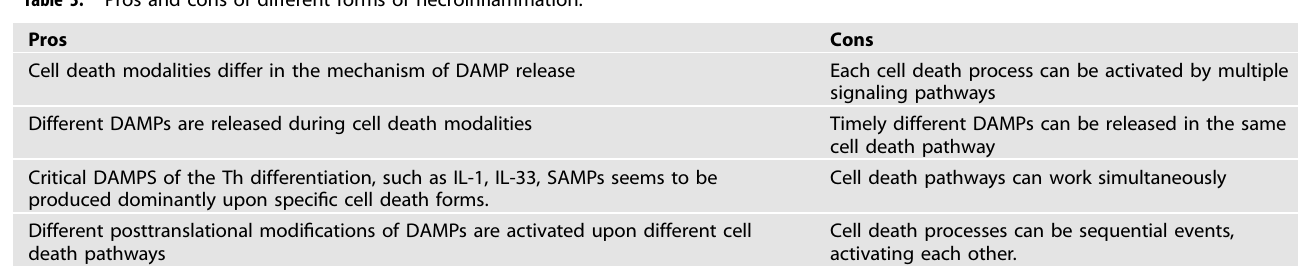
signaling pathways cell death pathway Cell death pathways can work simultaneously Cell death processes can be sequential events, activating each